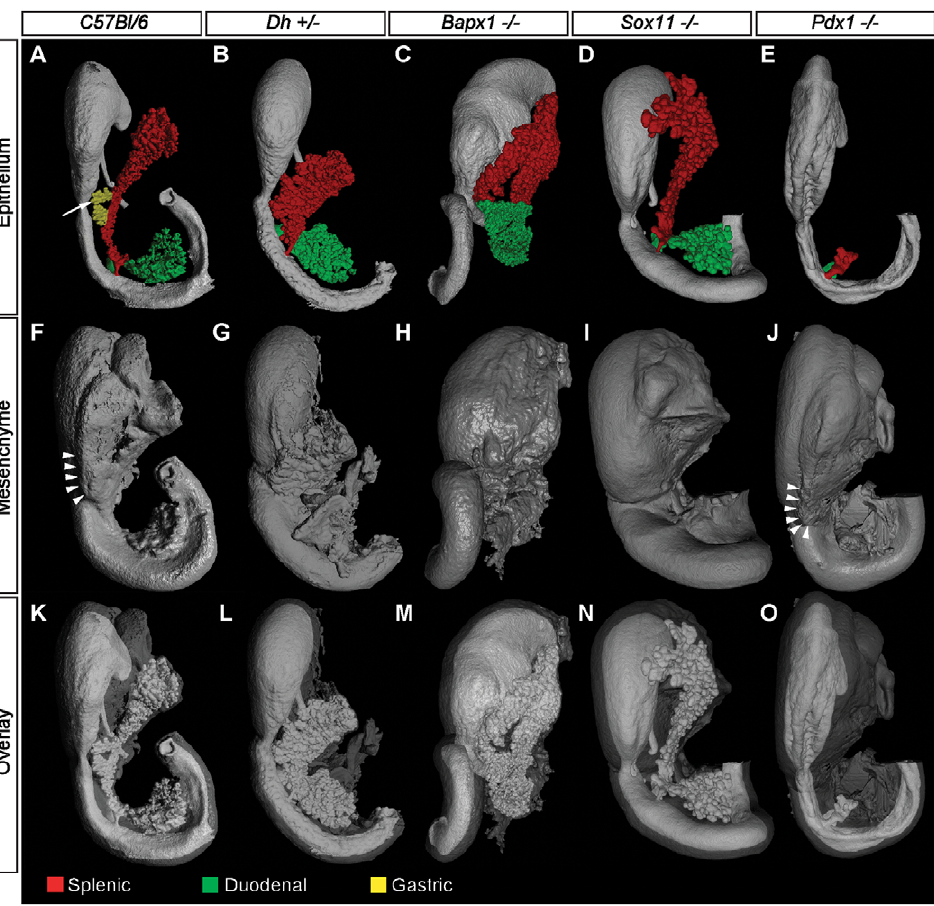
Figure 2. Disturbed splenogenesis perturbs formation of the gastric lobe mesenchymal domain. ( A through O ) OPT generated iso- surface reconstructions of the e14.5 pancreatic region from normal C57/Bl6 ( A , F , K ), Dh + / 2 ( B , G , L ), Bapx1 2 / 2 ( E , H , M ), Sox11 2 / 2 ( D , I , N ) and Pdx1 2 / 2 ( E , J , O ) mice. Reconstructions include the stomach, duodenum, spleen and pancreas and is based on the signal from; E-cadherin antibodies (epithelium – light grey, A to E and K to O ) and the signal from tissue auto fluorescence (mesenchyme – dark grey, F to J and K to O). The incapacity to form a proper spleen primordium in Dh + / 2 , Bapx1 2 / 2 and Sox11 2 / 2 mice results in various degree of failure to separate the dorsal and gastric lobe mesenchyme. Thereby development of the entire dorsal epithelial region is perturbed (compare B to D with A ). The gastric lobe is indicated by an arrow in ( A ). As indicated by mesenchymal morphogenesis in the Pdx1 mutant, formation of the GL mesenchymal domain is an autonomous event independent of pancreatic epithelial development (arrowheads, F and J ). In ( A to G ) the dorsal, ventral and gastric lobes have been pseudocolored red, green and yellow respectively. The specimens are not depicted to scale.